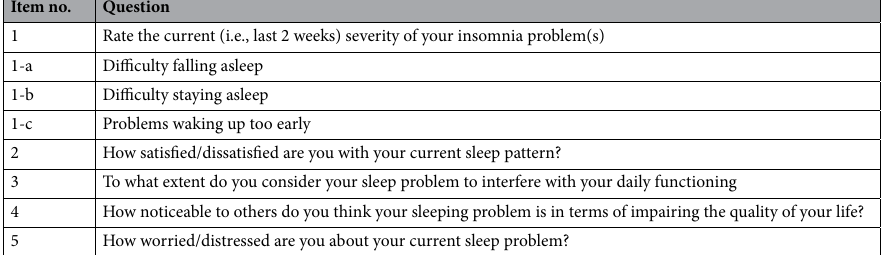
Table 1. Insomnia severity index items (scores of each item is 0–4; 0 = no problem or difficulty; 4 = very severe problem).